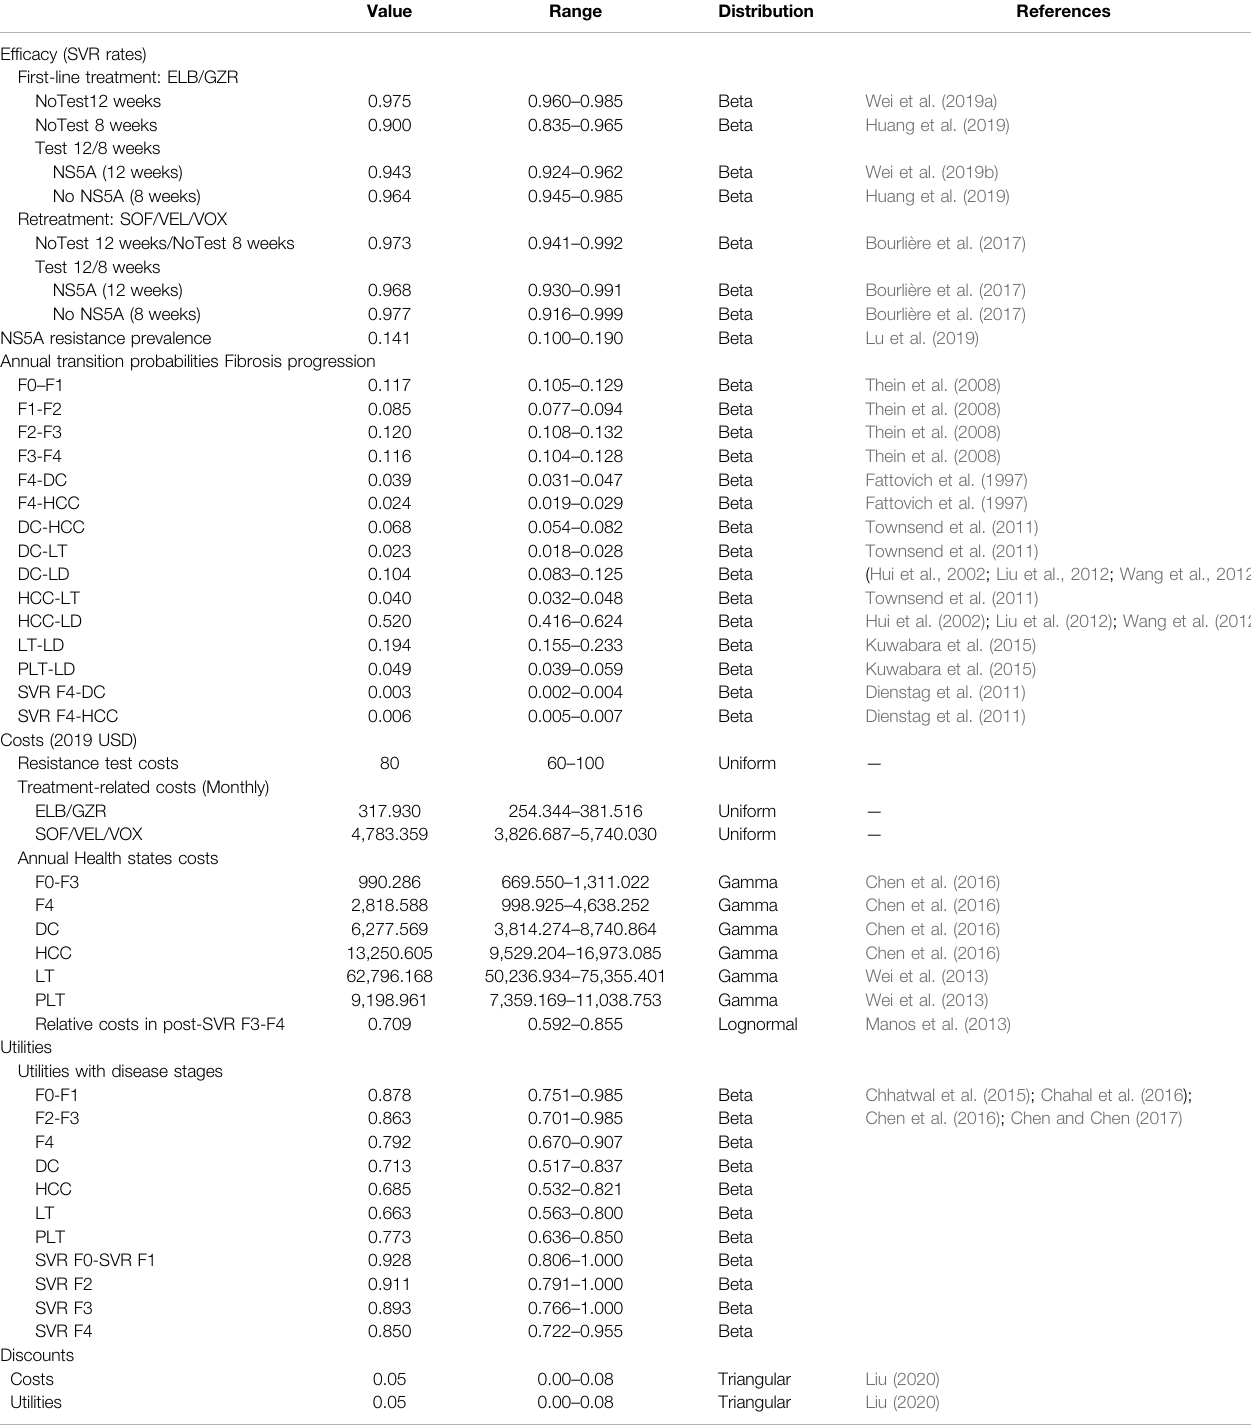
TABLE 1 | Summary of treatment, epidemiological, cost, and quality-of-life